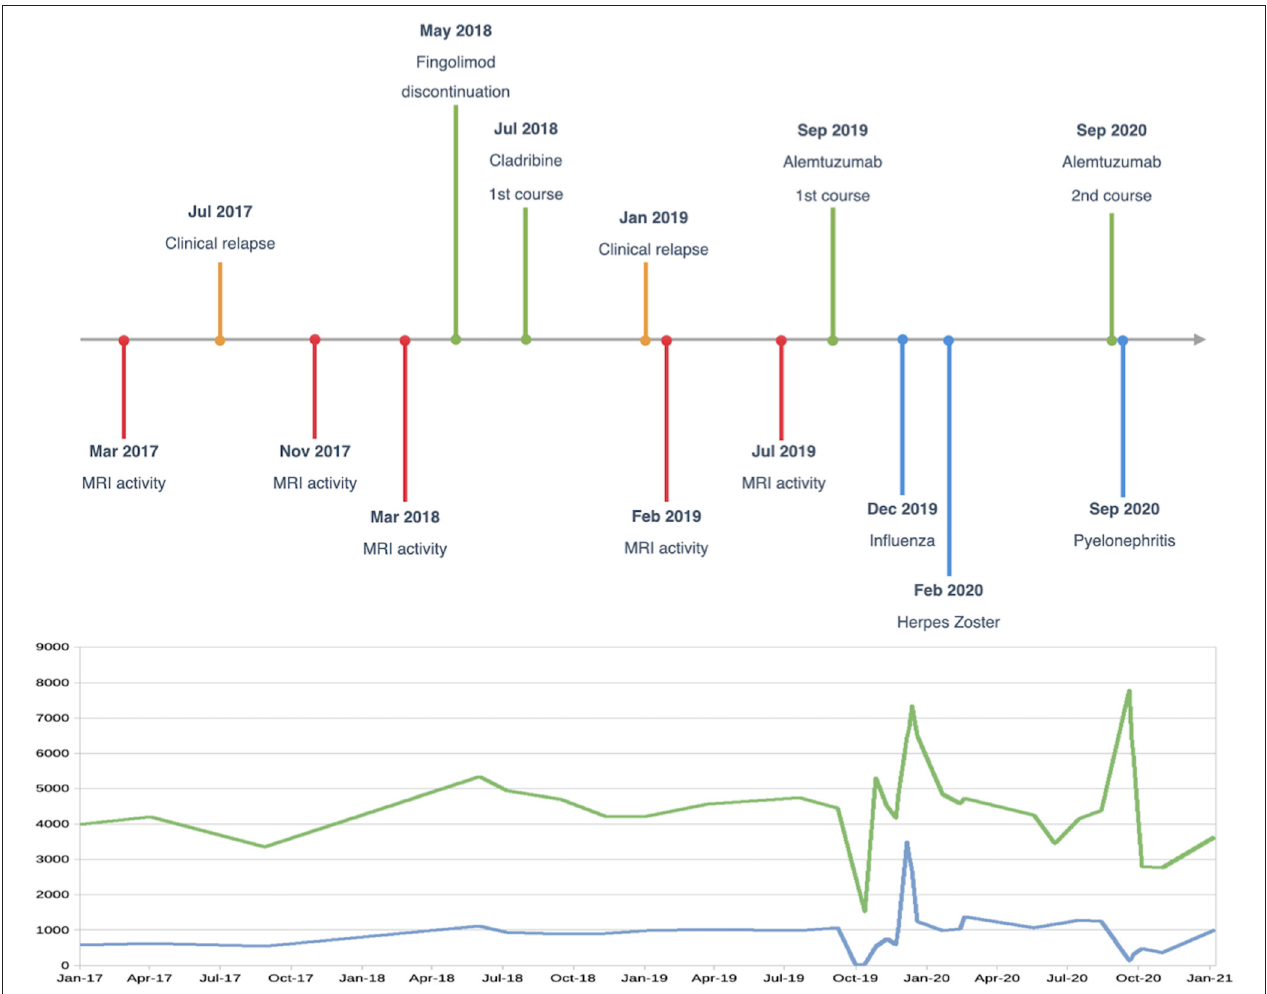
FIGURE 2 | Case timeline, and white blood cell (green line) and lymphocyte (blue line) changes over time (cells/ µ l).